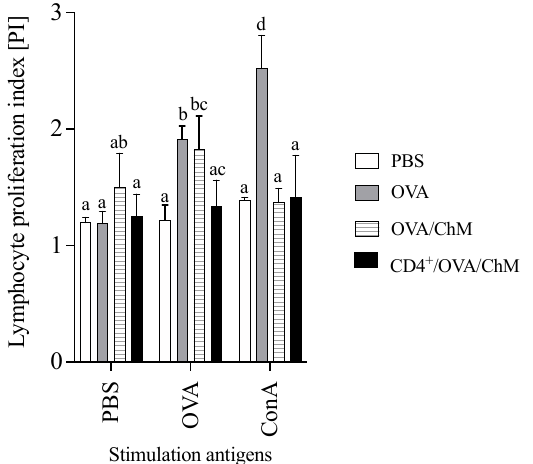
Figure 3. Proliferation index (PI) of lymphocytes from PBS, OVA, OVA/ChM, and CD4 + /OVA/ChM groups: unstimulated (PBS), and stimulated with ovalbumin (OVA) or concanavalin A (ConA; assay positive control). Two-way ANOVA with a post hoc Tukey test was used to determine statistical differences. The bars represent the mean of the group ( n = 3) ± SD. a,b,c,d Mean values with different superscripts are different at p ≤ 0.05.